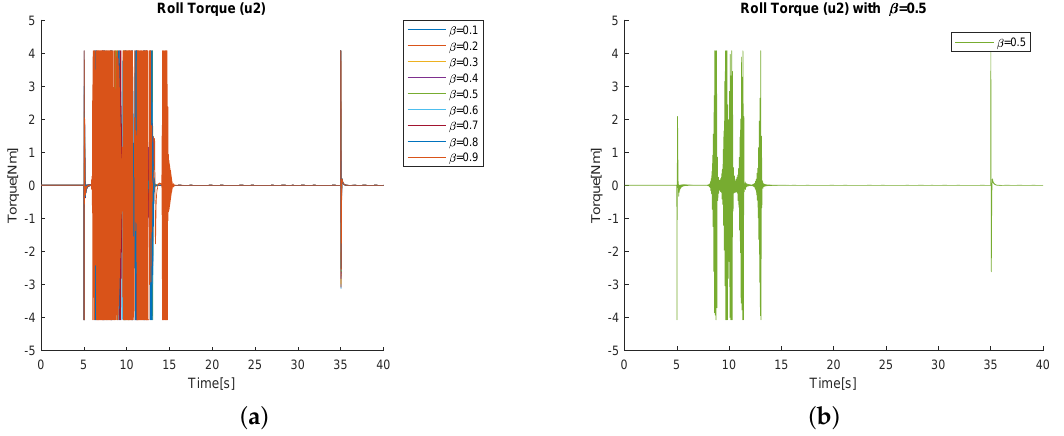
Figure 13. ( a ) Roll Torque with distinct β ’s; ( b ) Roll Torque with β = 0.5.